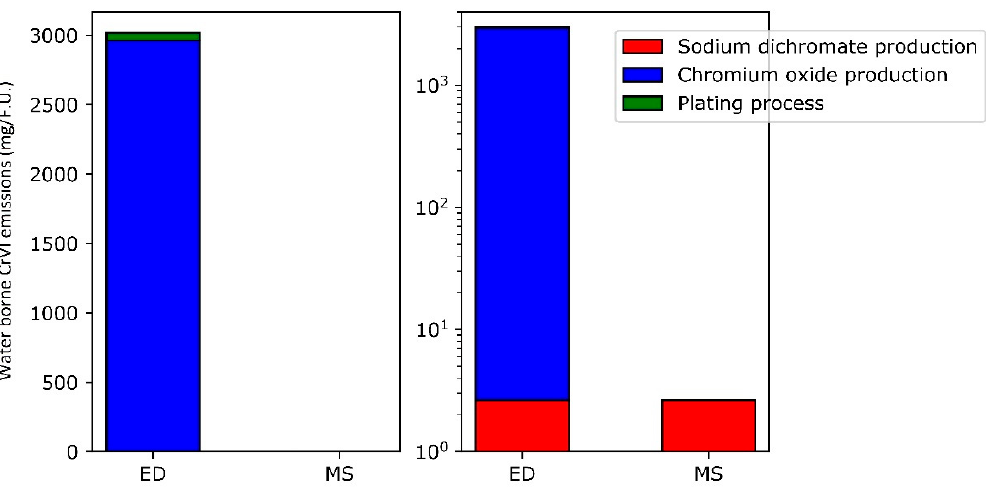
Figure 6. Hexavalent chromium waterborne emissions. Left = linear scale, right = logarithmic scale.